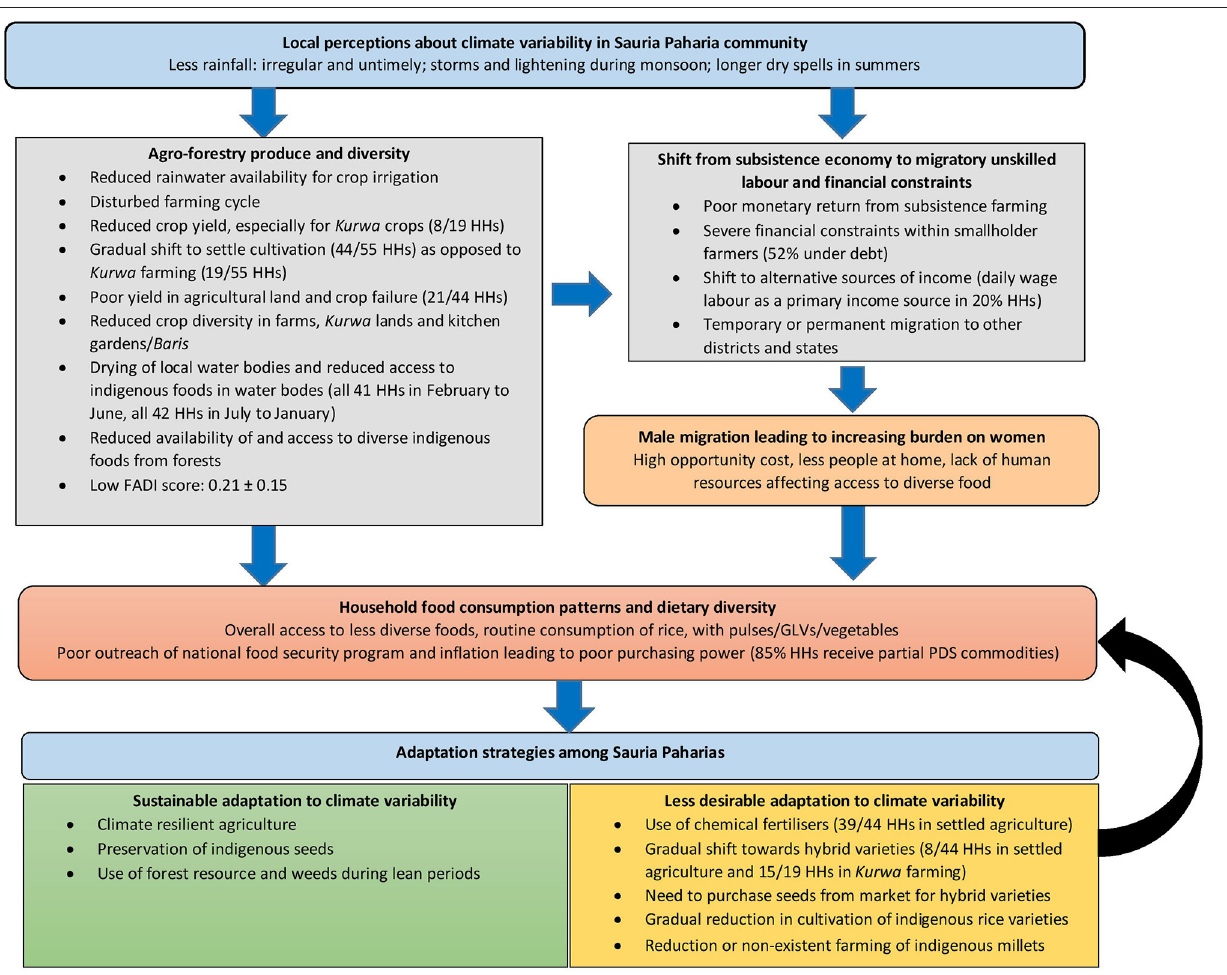
stated: “There is very less rainfall now, because of that there is drought in the village” (Respondent number 1, male, study village two, Boarijor